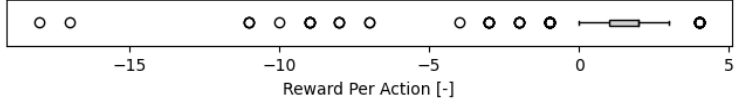
Figure 15. Average reward per action obtained by the RL agent in one training episode.